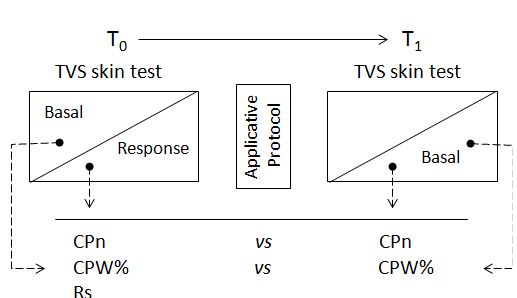
Figure 2. Camianta